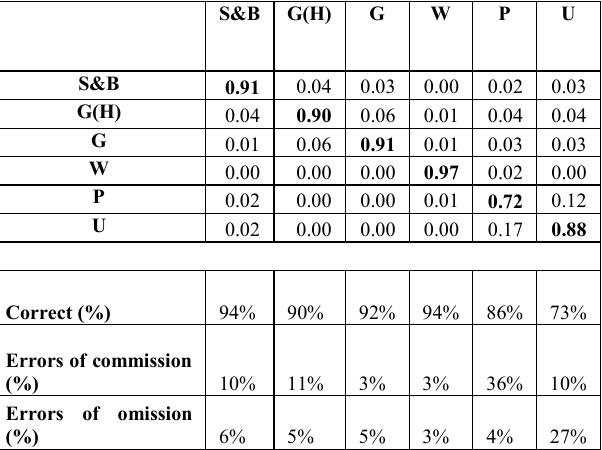
Table 2. Accuracy assessment for the RF classification of the 2009 image. S&B: Shrubs and bushes; G(H):